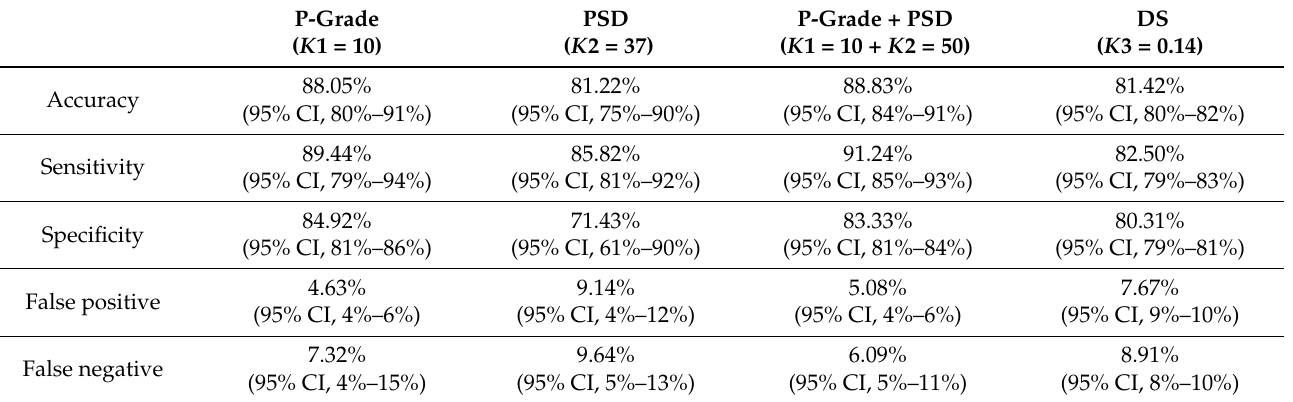
Table 3. Accuracy, sensitivity, specificity, false-positive rate, and false-negative rate for spondylolis- thesis